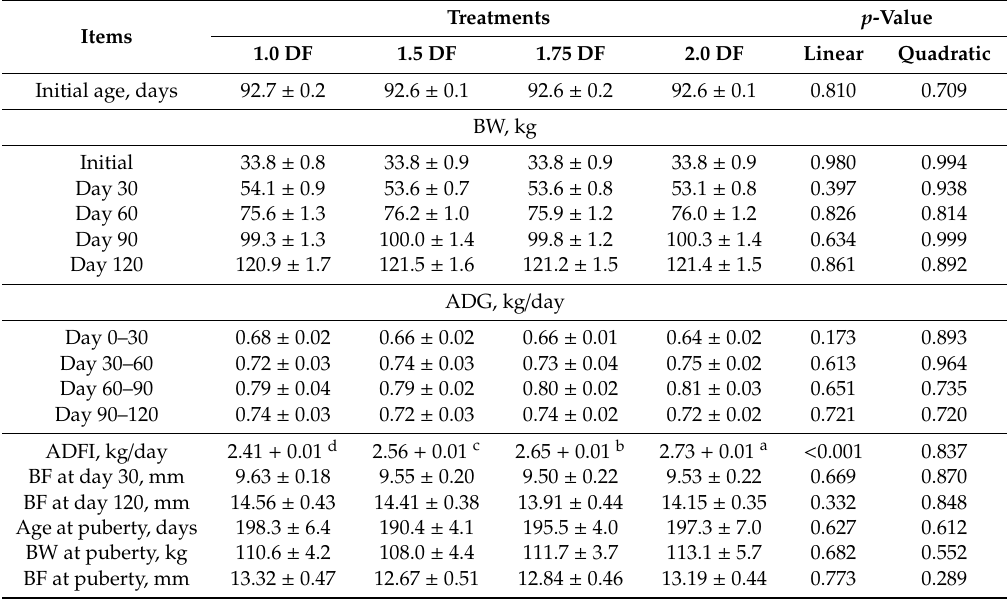
Table 4. E ff ects of dietary fiber levels on growth performance and pubertal onset in gilts.